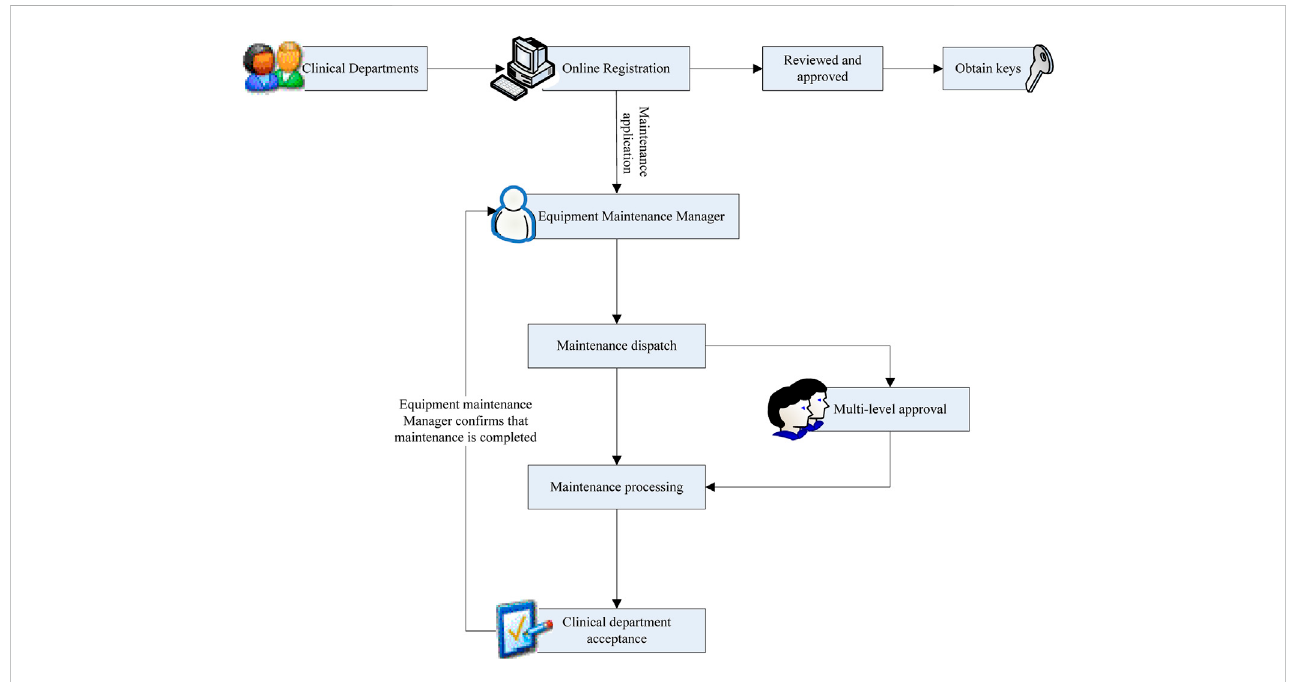
FIGURE 4 Equipment maintenance management